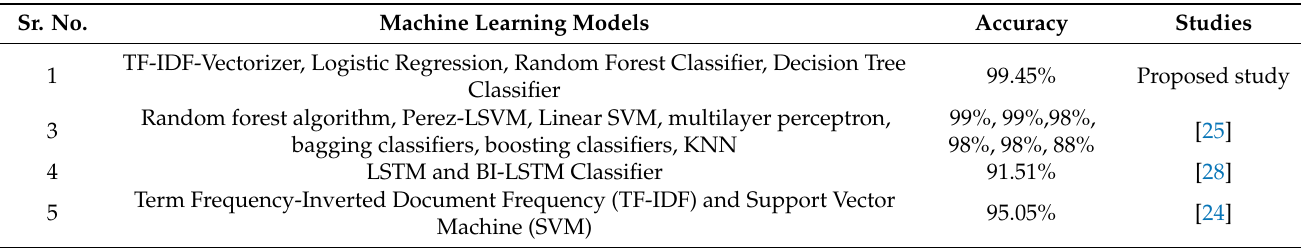
Table 6. Comparison of our work with other